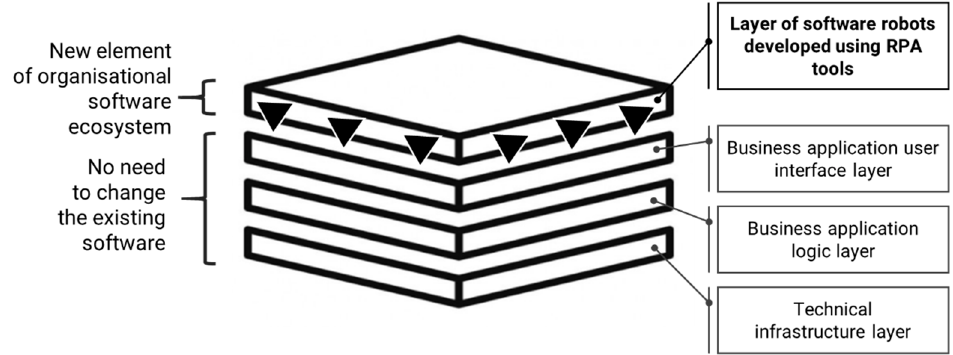
Figure 1. Positioning of software robots developed using robotic process automation (RPA) tools. Source: proprietary compilation.